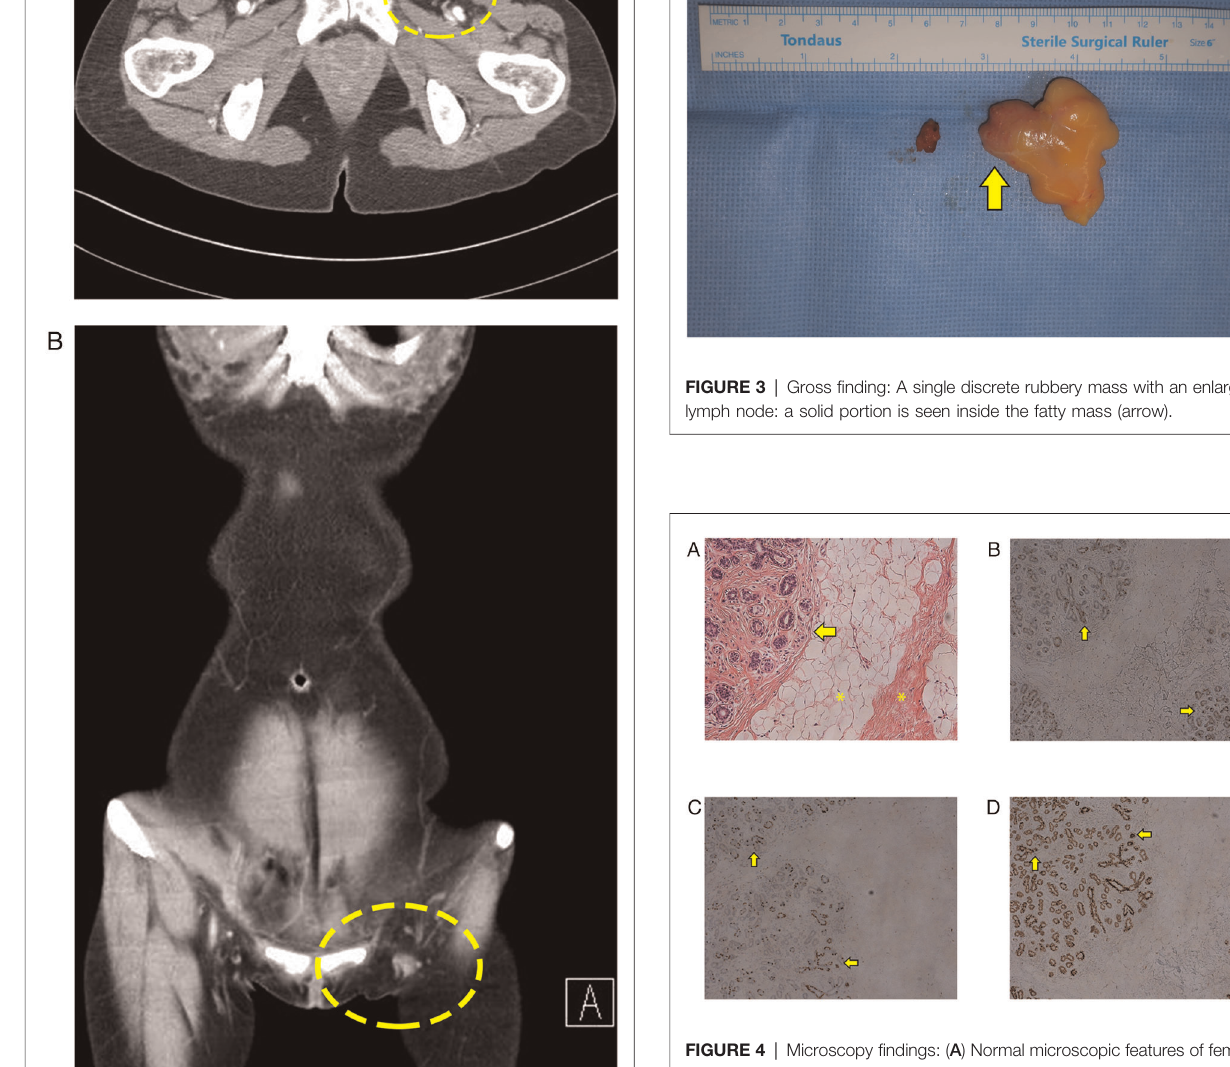
FIGURE 4 | Microscopy fi ndings: ( A ) Normal microscopic features of female breast tissue are evident. Multiple ducts lined by myoepithelial and epithelial cells (arrow) with surrounding stroma and adipose tissue (asterisks) are seen. ( B ) Immunohistochemistry (IHC) staining for estrogen receptor (ER) showing positivity throughout the whole glandular epithelium (arrow). ( C ) IHC staining for progesterone receptor (PR) showing positivity throughout the glandular epithelium. ( D ) IHC staining for GATA binding protein 3 showing